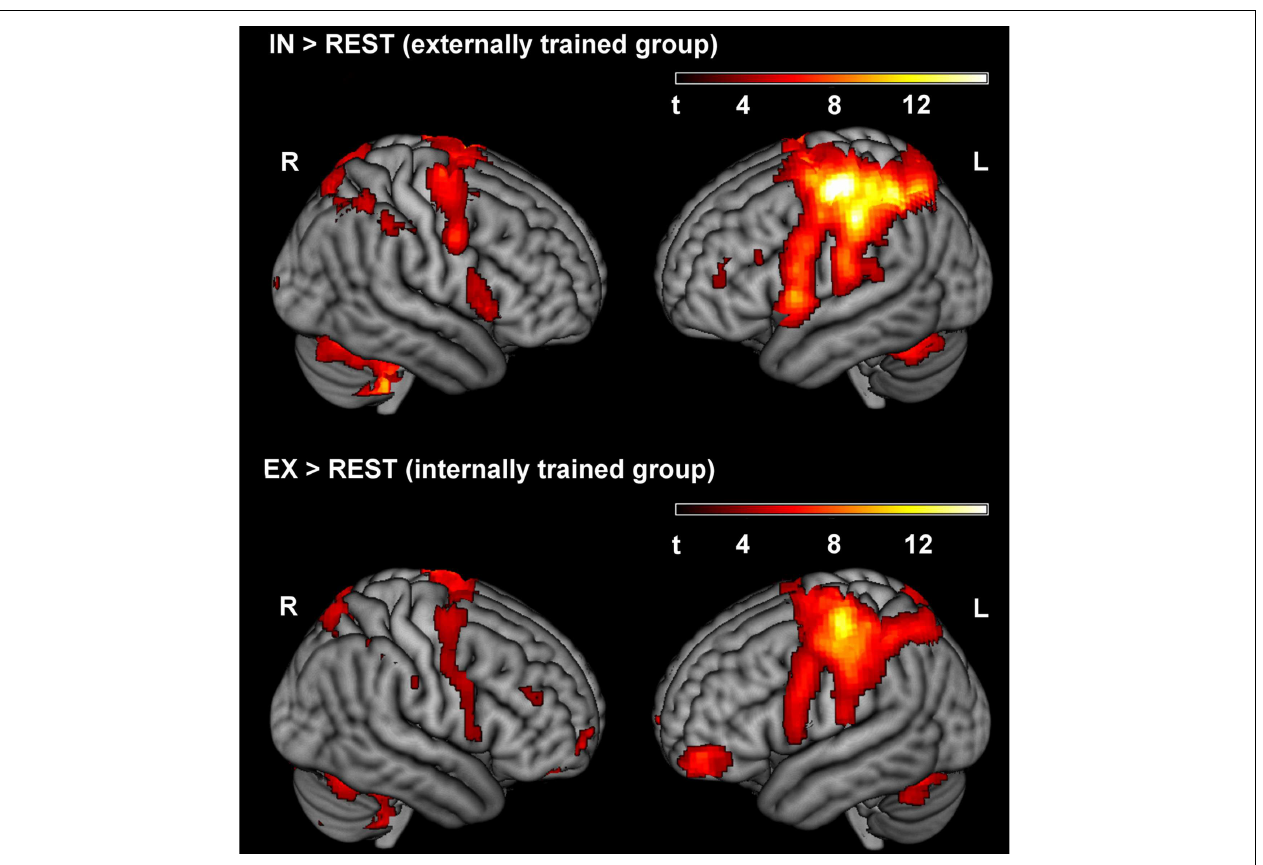
FIGURE 3 |Activated clusters for IN > REST and EX > REST of the second run, respectively ( p < 0.001, uncorrected ). During the second run, the externally trained group adopted the internal focus of attention, whereas the internally trained group focused externally.